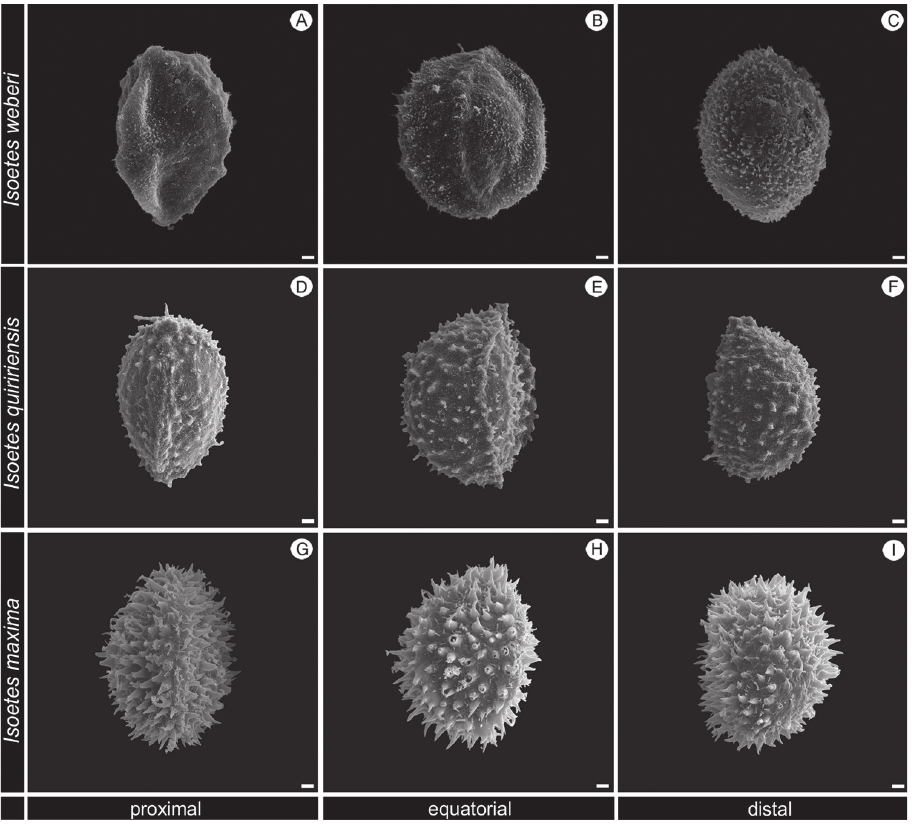
5' Sporangia whitish or castaneous throughout; megaspores verrucate with rounded to slightly elongated verrucae (not more than twice longer than wide), megaspores microsculpture (SEM) with terminal ends of anastomosed bars joined forming bacillae or echinulae ( I. quiririensis ) ............................. 6 6 Velum covering 1/3–3/4 of the sporangial surface; megaspore laevigate to obscurely verrucate, megaspores microsculpture (SEM) with terminal ends of anastomosed bars joined forming only bacillae; microspores densely echinate, the spines narrow and sharp ......................................................... I. maxima 6' Velum covering more than 3/4 of the sporangial surface; megaspores con- spicuously verrucate, megaspores microsculpture (SEM) with terminal ends of anastomosed bars joined forming bacillae or more rarely echinulae; micro- spores sparsely echinate, the spines broad and obtuse .............. I.